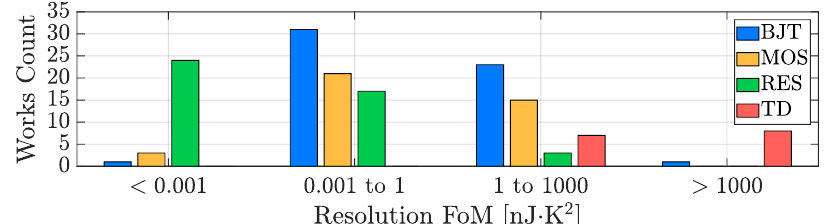
Figure 19. TDC energy efficiency performance distribution with sensing-type distinction.